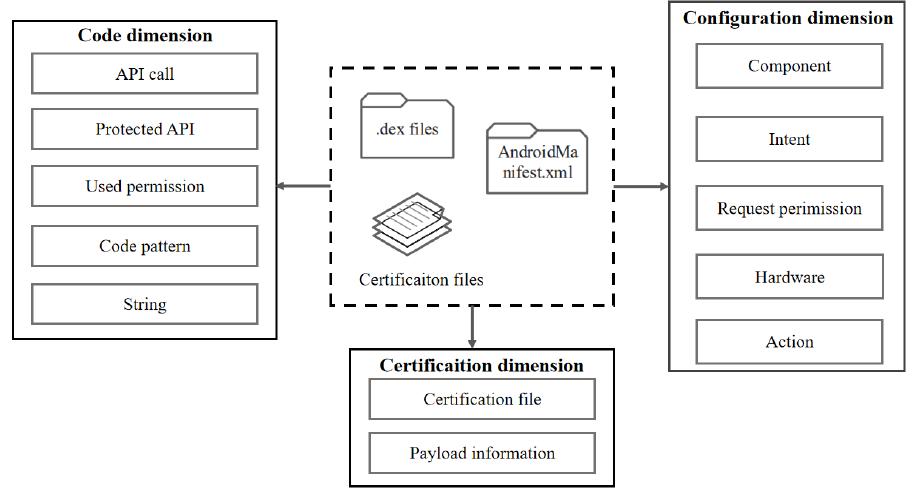
Figure 2. Static behavioral characteristic extraction.